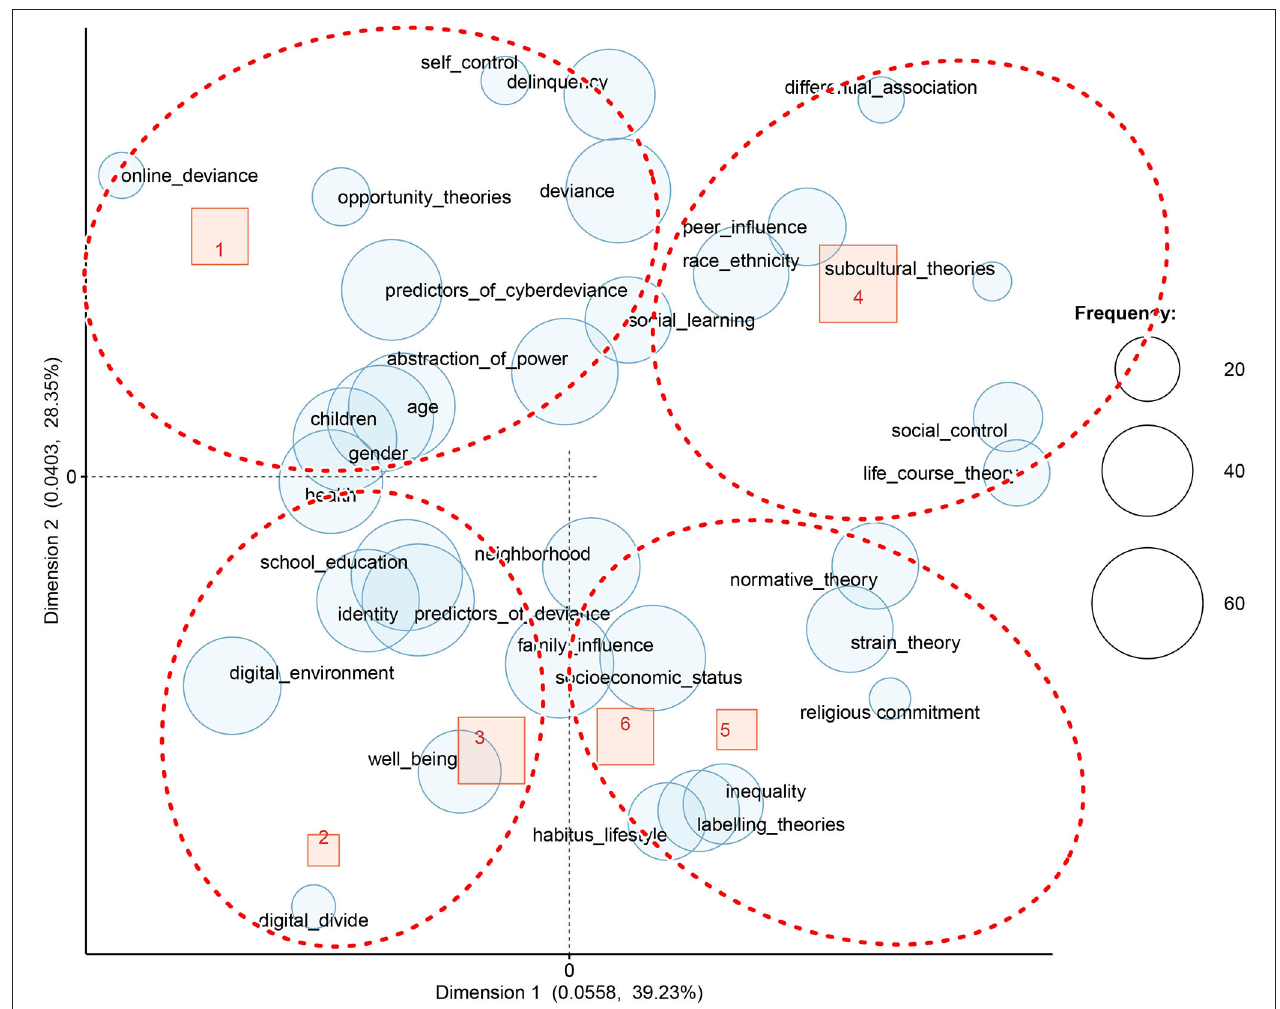
FIGURE 6 | Correspondence analysis of codes and hierarchical clusters in extenso